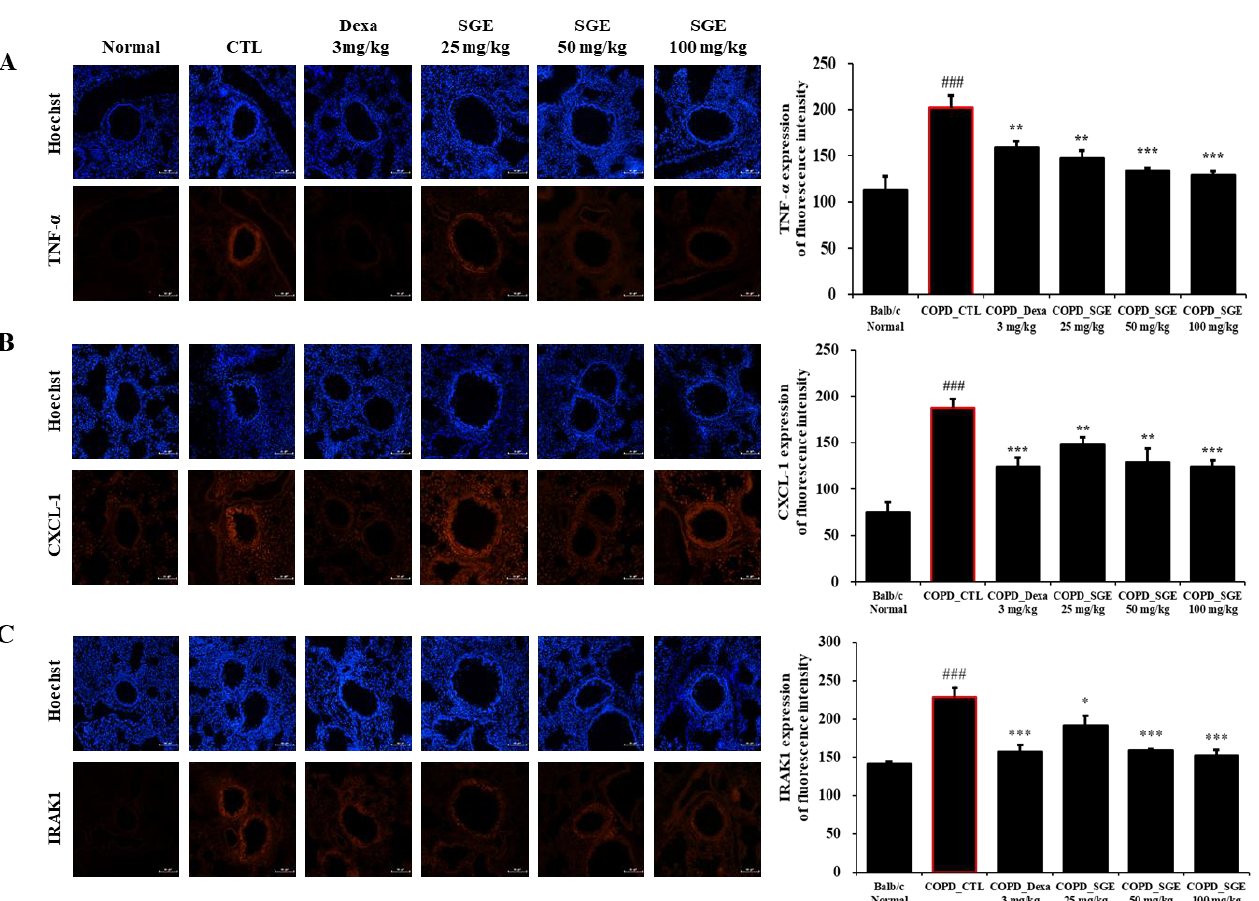
Figure 7. Effect of SGE on TNF- α , CXCL1, IRAK1 using immunofluorescence analysis of lung tissue from COPD-induced mice. Sectioned COPD-induced mouse lung tissue was stained with ( A ) TNF- α , ( B ) CXCL-1, or ( C ) IRAK1 antibodies and visualized as red fluorescence. Hoechst was used as a nuclear stain with blue fluorescence. Fluorescence for each factor is shown in a quantitative bar graph. Scale bar = 100 µm. The data are presented as means ± SEM (n = 6 mice) for individual mice. ### p < 0.001 compared to normal, and * p < 0.05, ** p < 0.01, and *** p < 0.001 compared to control. Dexa, dexamethasone.